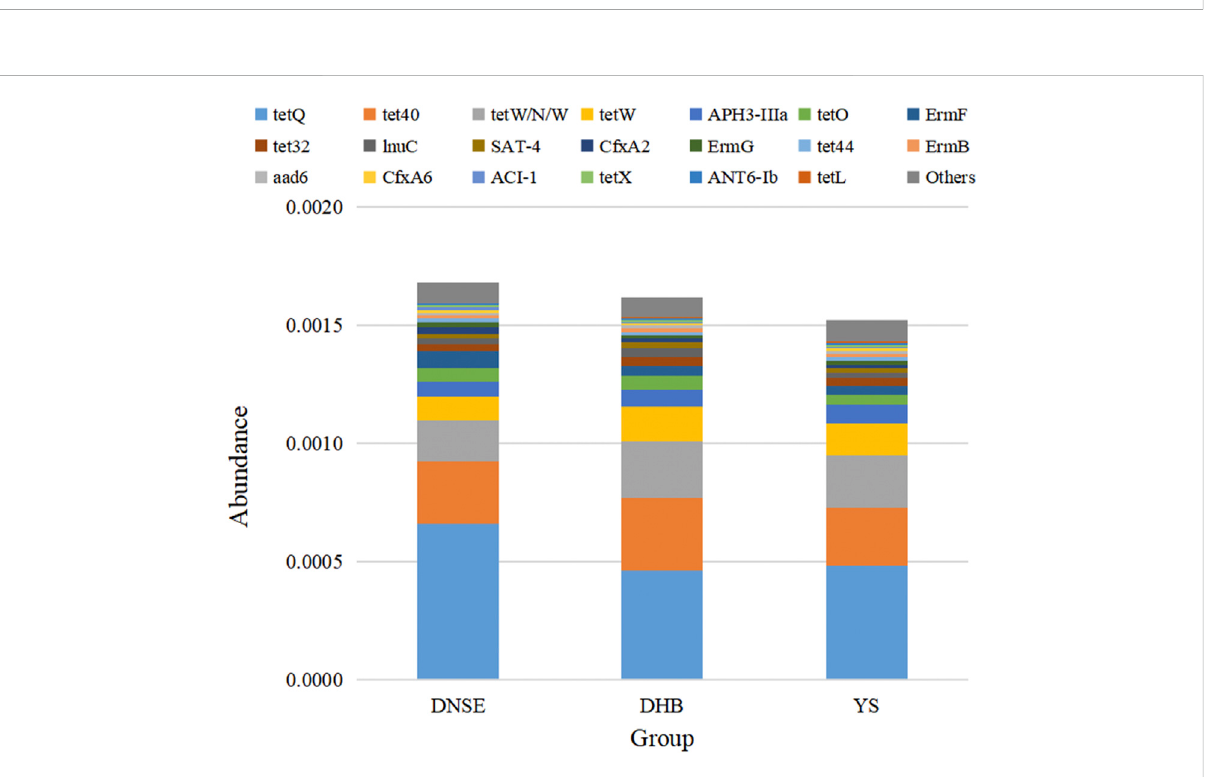
FIGURE 6 The 20 most abundant